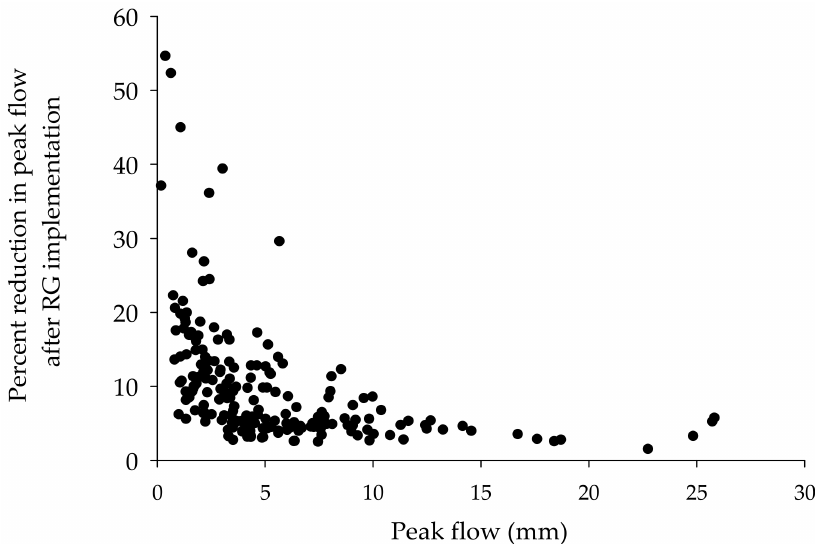
Figure 6. Percentage reduction in peak flow after RG implementation (100% scenario) vs. peak flow (mm) during the simulation period at the watershed outlet. Peak flow was estimated as any flow that was one standard deviation above the mean simulated daily flow for the study period or flow on the day following peak flow conditions, as described (to capture part of the falling limb of the